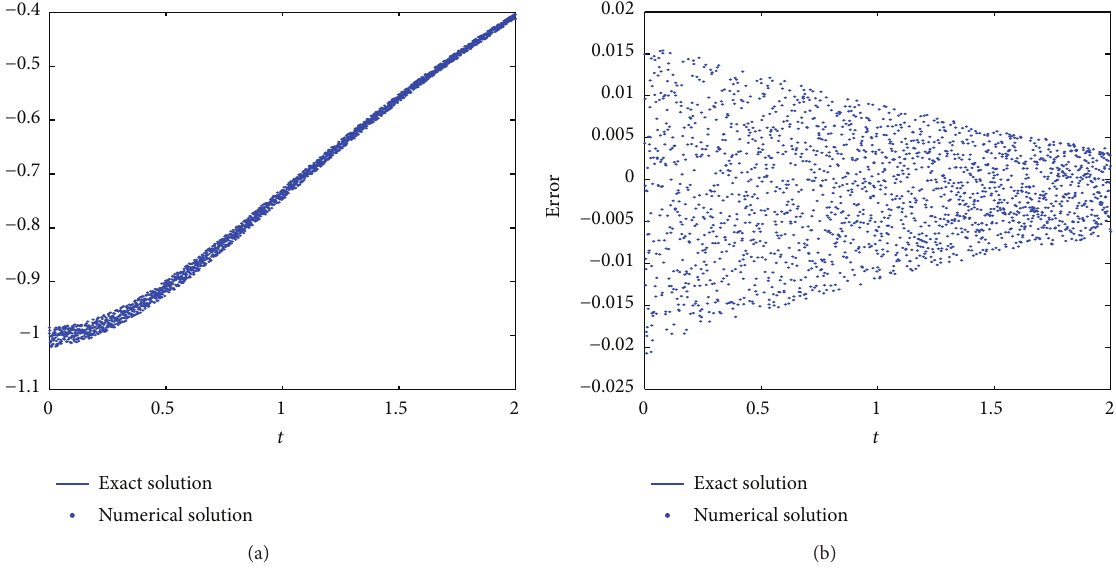
̂𝑓(𝑡) ̂𝑓(𝑡) (a), the error 𝑓(𝑡) − (b) with 𝑞 = 0.01